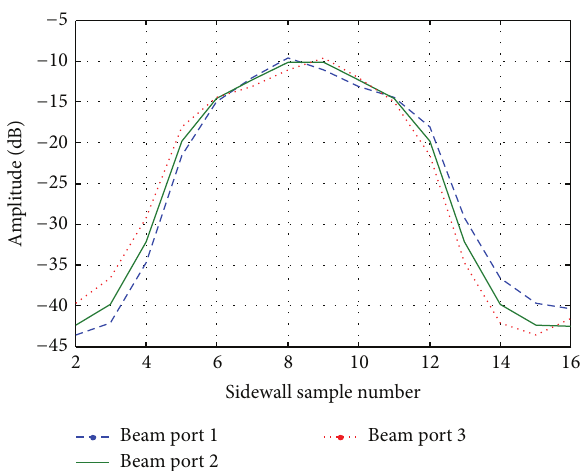
Figure 5: Beam to sidewall coupling amplitude.